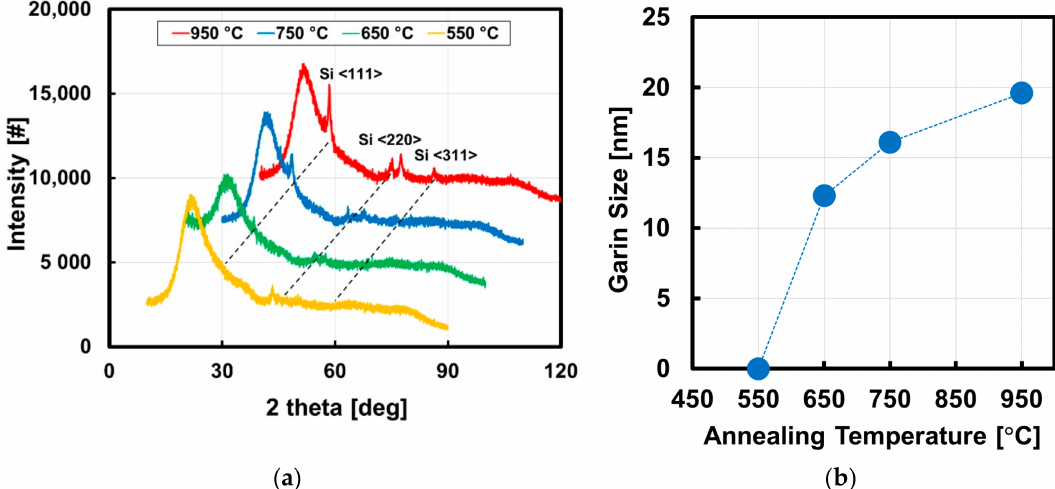
Figure 5. ( a ) XRD spectra of CuIC p-type micro-Si thin films fabricated on a quartz glass substrate. Note: the 2nd, 3rd and 4th XRD spectra are shifted by 10 ◦ , 20 ◦ and 30 ◦ , and by 2500, 5000 and 7500 units on the horizontal and vertical axes, respectively, for more clarity, ( b ): the calculated grain size of the CuIC micro-Si films formed in < 111 > plane vs. annealing